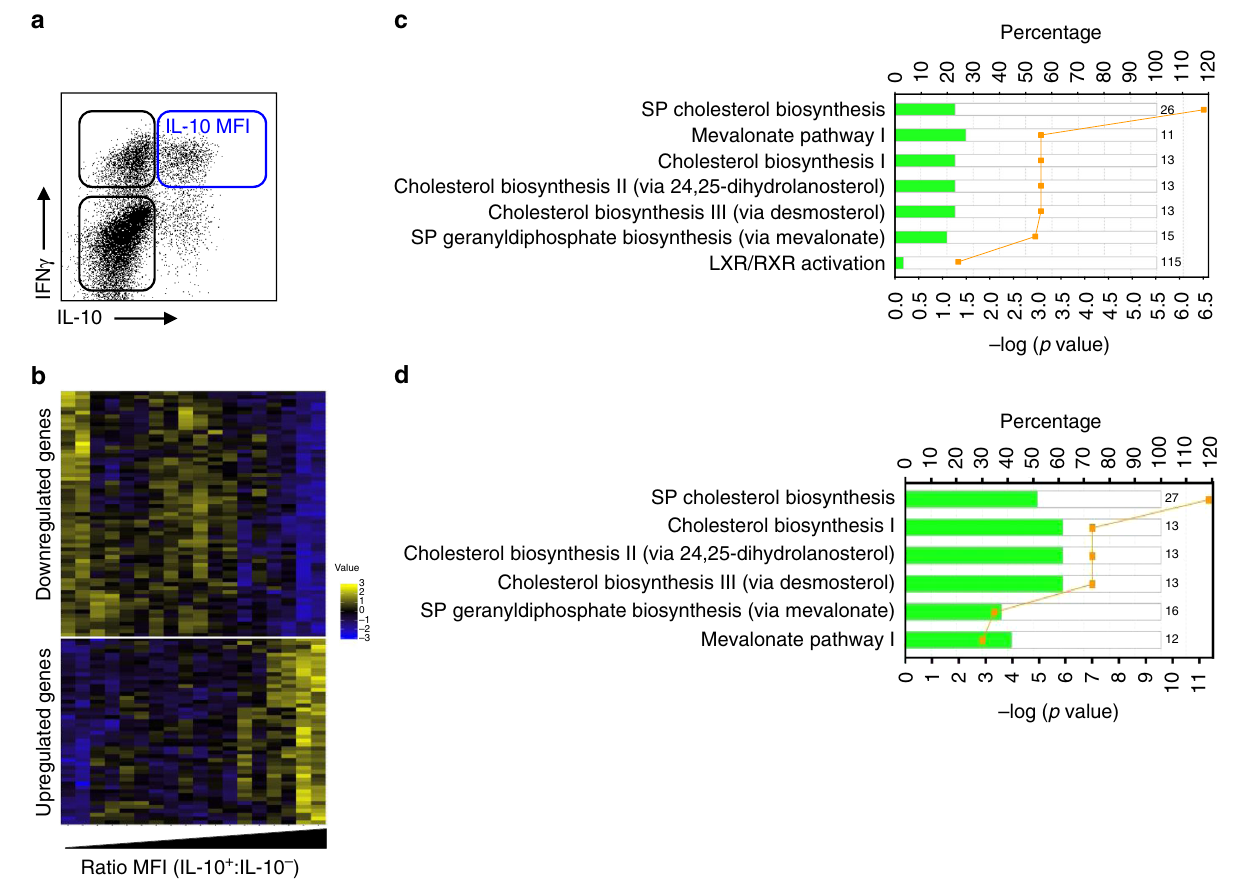
Fig. 1 Metabolic regulation of T-helper type 1 (Th1) switching in primary human CD4 + T cells. a Schematic fl ow cytometric dot-plot of the life cycle of human Th1 switching; double-positive cells are highlighted with a blue gate, while IL-10-negative populations are shown within a black gate; b Heatmap of 111 signi fi cantly expressed genes in the double-negative (IFN γ − IL-10 − ) and single-positive (IFN γ + IL-10 − ) populations associated with changes in IL-10 protein expression, as measured by median fl uorescence intensity ratio (MFI + :MFI − ) for IL-10 expression in the double-positive (IFN γ + IL-10 + ) population. c Ingenuity Pathway Analysis (IPA) based on genes from b (SP: superpathway). Bars represent the percentage of the number of genes mapping to a particular pathway, coloured in green to note the inverse correlation. The number indicates the number of total genes ascribed to the pathway. The yellow line represents the P value as calculated by Fisher ’ s test and corrected for multiple testing using the Benjamini – Hochberg correction. d IPA based on genes differentially expressed between CYT-1- and CYT-2-expressing Jurkat T cells and analysed and annotated as in